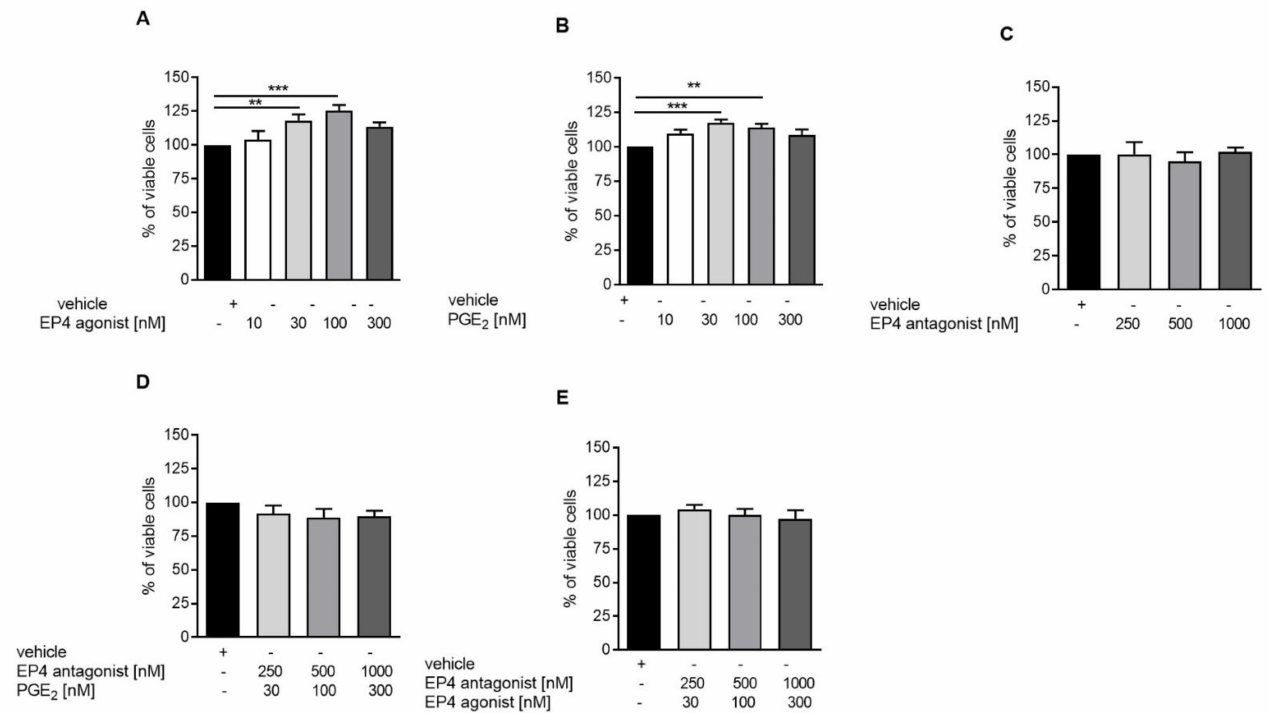
Figure 4. EP4 receptor agonism increases tubular proliferation in vitro. To evaluate proliferative capacity of DCT cells, the MTS test was performed. DCT cells were treated with vehicle, EP4 receptor agonist ( A ), PGE2 ( B ), EP4 receptor antagonist ( C ), and the EP4 receptor antagonist together with PGE2 ( D ), as well as EP4 receptor antagonist together with EP4 receptor agonist ( E ) under starving conditions for 72 h. Data are provided as mean ± SEM from at least five independent experiments.